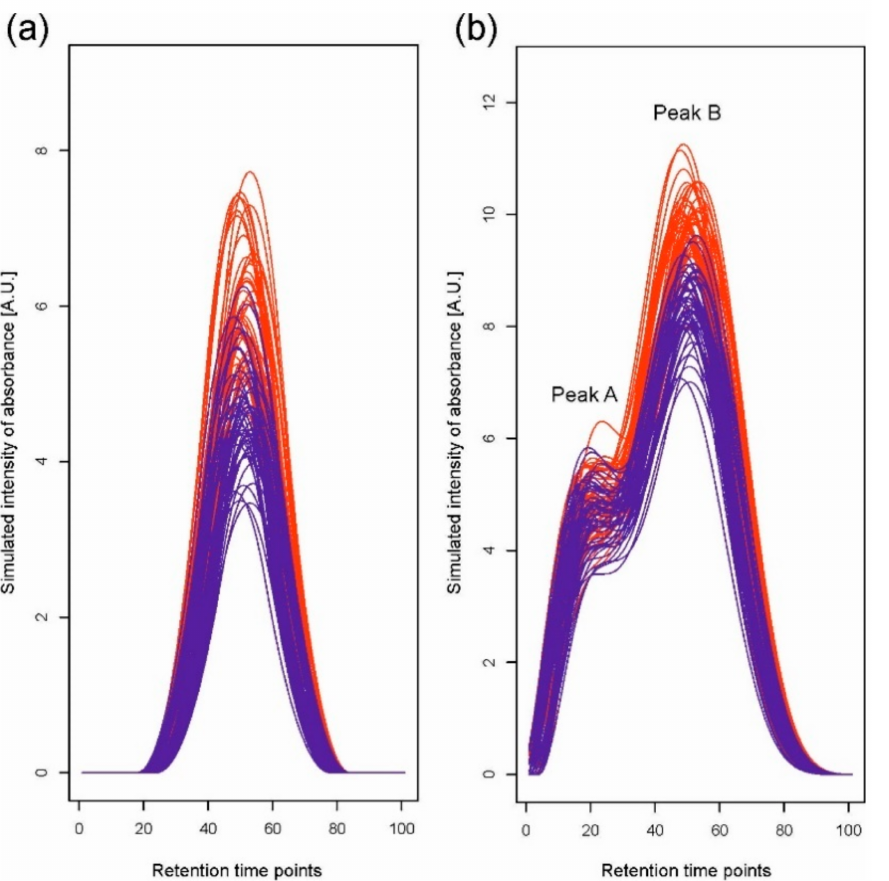
Figure 1. One of the simulated datasets for ( a ) a single peak and ( b ) a double peak, which consists of two overlapping peaks, A and B. Different colors indicate different experimental